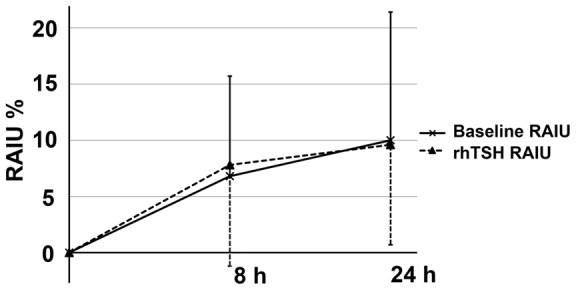
Primary thyroid tumor RAIU in 9 dogs with thyroid tumors.The mean and standard deviation of the 8 h- and 24 h-RAIU with and without rhTSH stimulation are given.